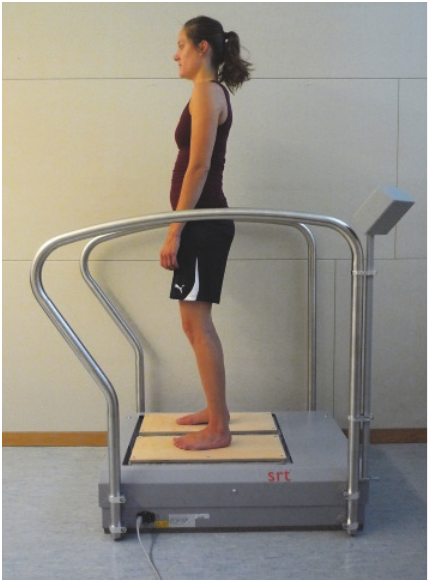
Figure 1: Starting position on